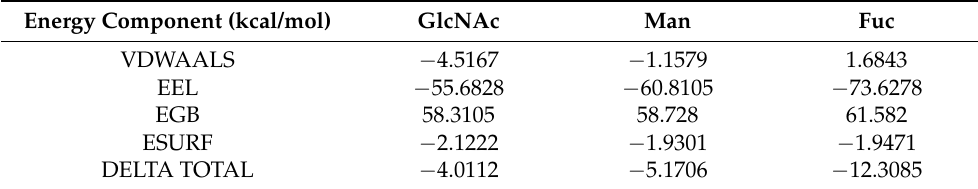
Table 1. The MM-GBSA of three monosaccharides binding with DC-SIGN. Energy Component